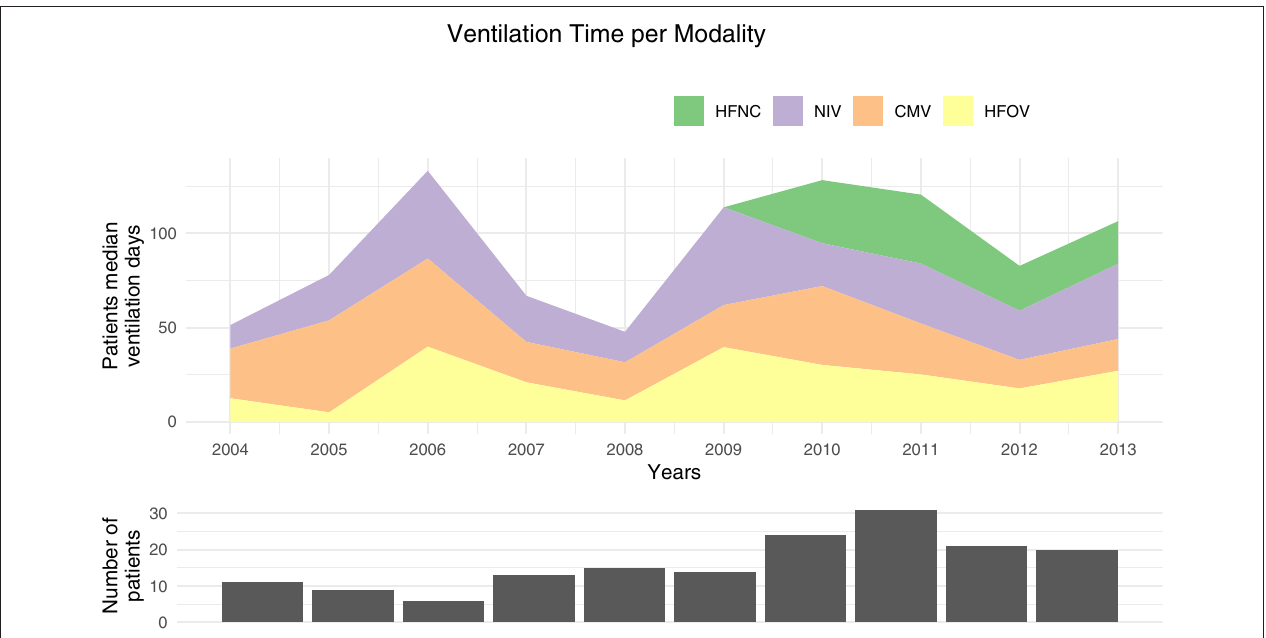
FIGURE 2 | Median ventilation time per patient for each modality. HFNC, high-flow nasal canula; NIV, noninvasive ventilation; CMV, conventional mechanical ventilation; HFOV, high frequency oscillatory ventilation.